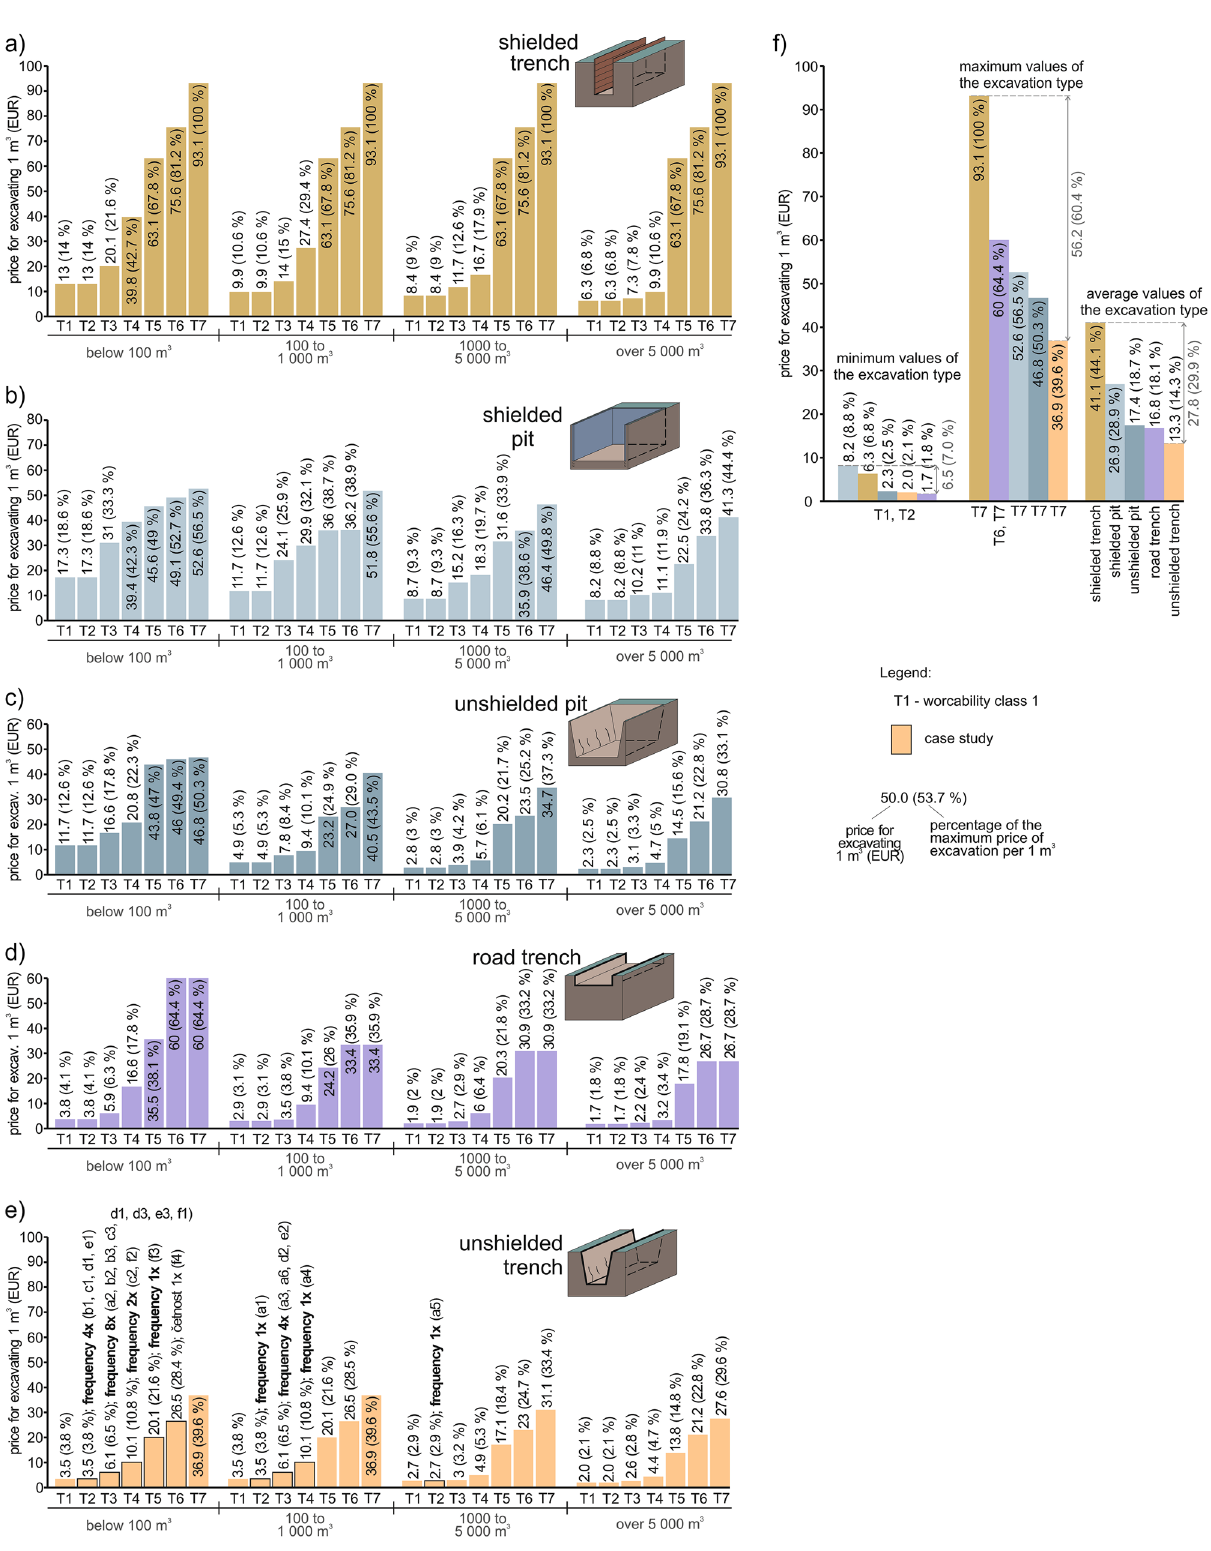
Figure 6. Graphs of the different types of excavations and technologies used; ( a ) shielded trench; ( b ) shielded pit; ( c ) unshielded pit; ( d ) road trench; ( e ) unshielded trench; ( f ) minimum, maximum and average price of each excavation type and